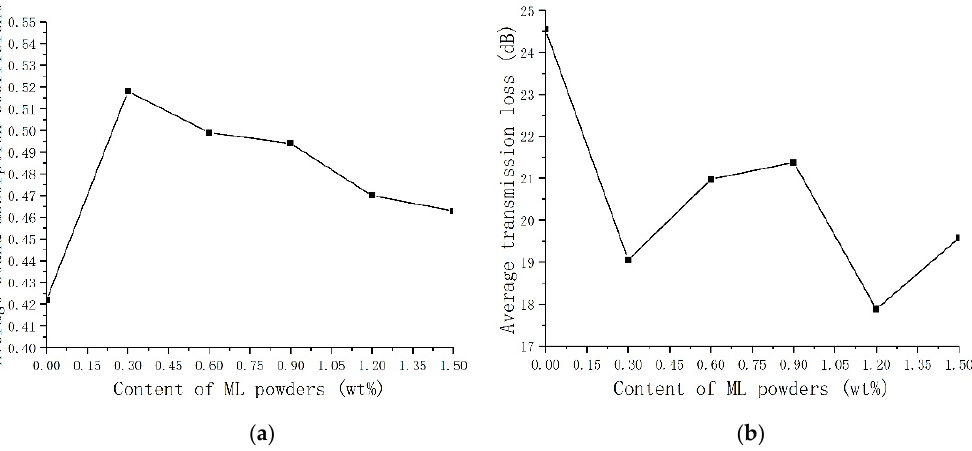
Figure 12. Average Sound absorption coefficient ( a ) and transmission loss ( b ) of TOPUF adding different mass of ML powders.